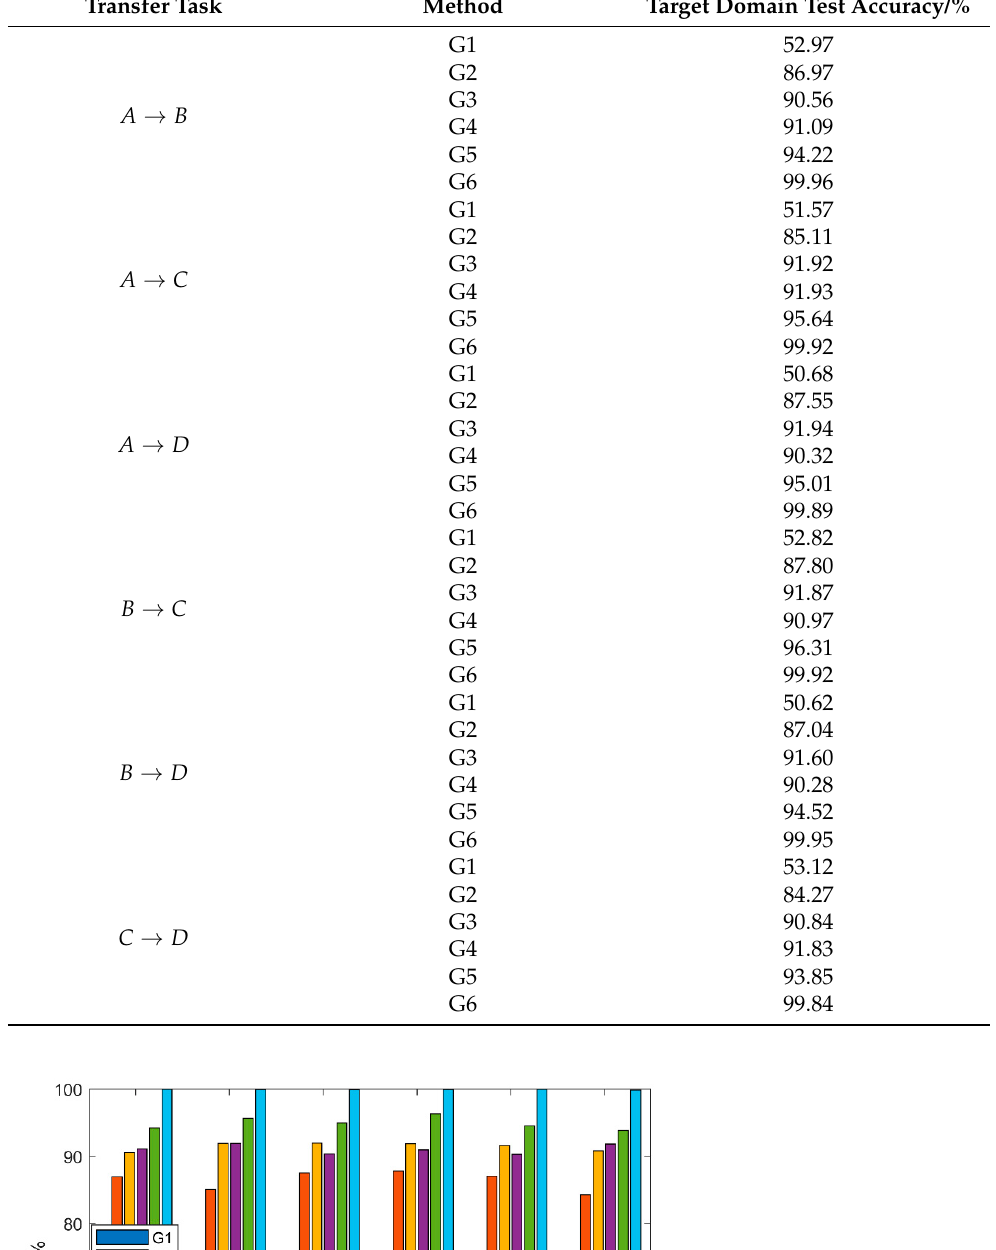
Table 9. Diagnostic performance under different diagnostic methods.